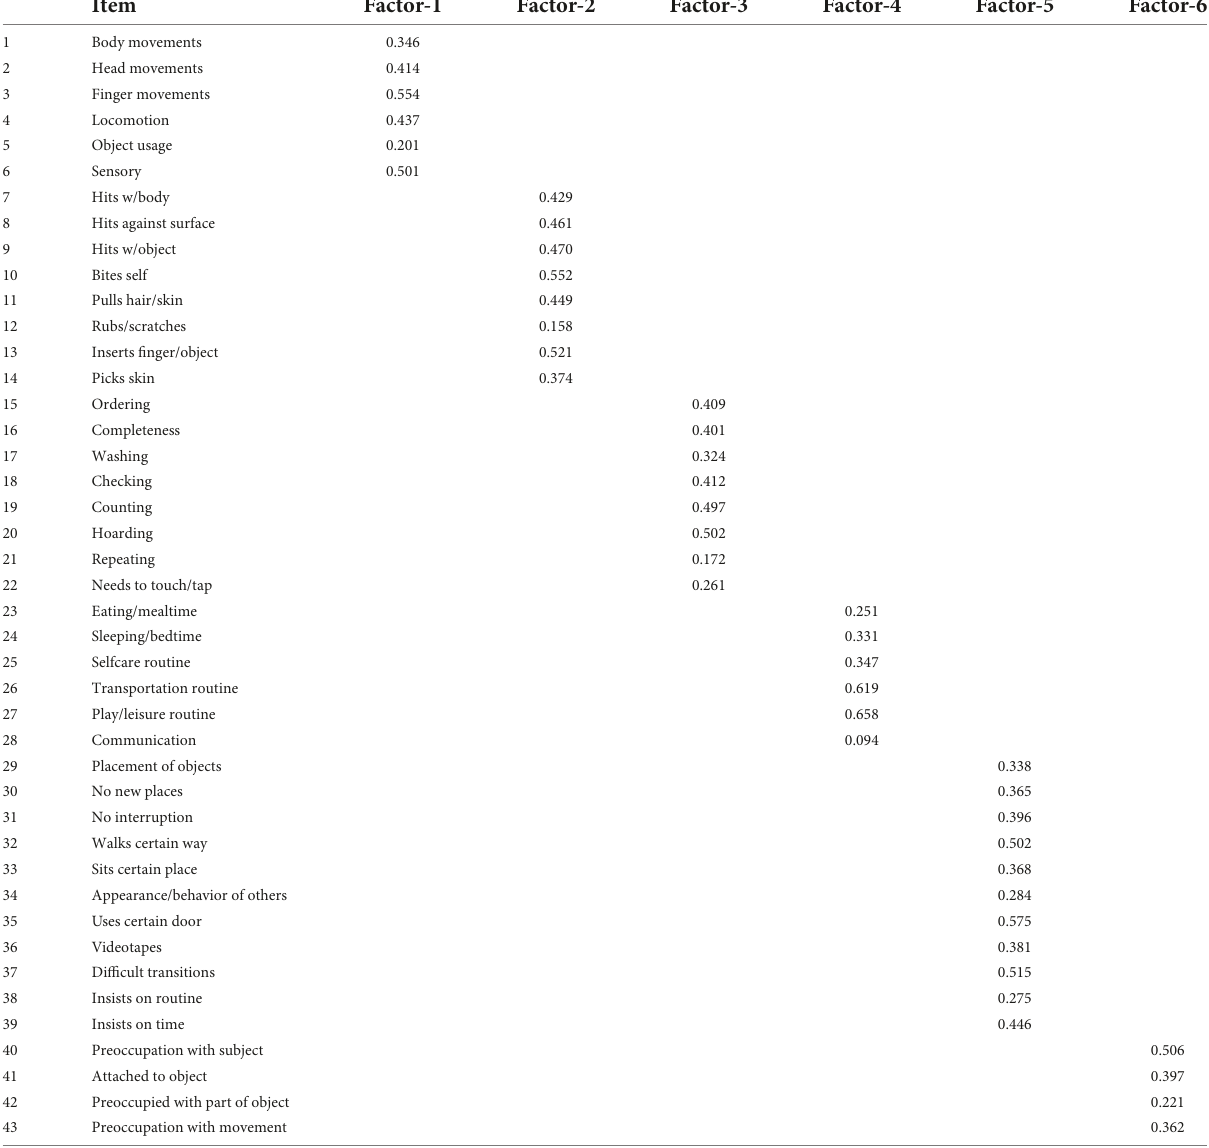
TABLE 4 The standardized factor loadings of the confirmatory factor for